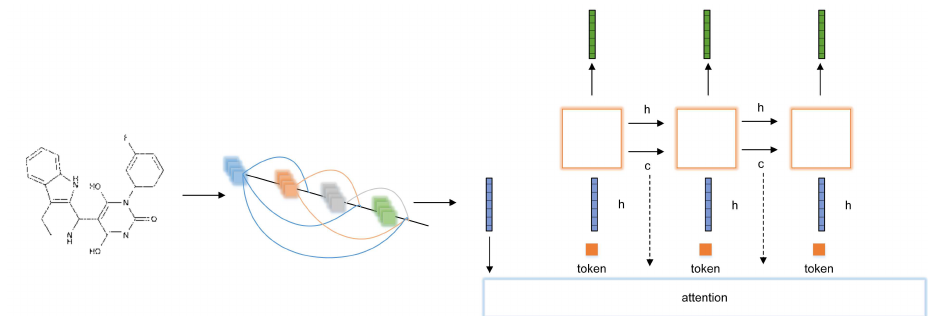
Figure 5. The combination of convnets and transformer. The red box represents the complete transformer structure, and the yellow box is the structure we use as an analogy to ViT. Note that here we use ResNet to symbolize convnets; in the actual experiment, we had two options here, ResNet and EfficientNet (the same in Figure 6).